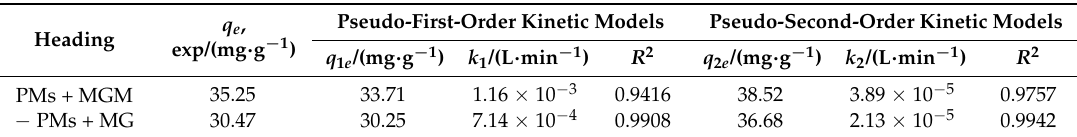
Table 2. Kinetic parameters for adsorption of MG with M-PMs and PMs.